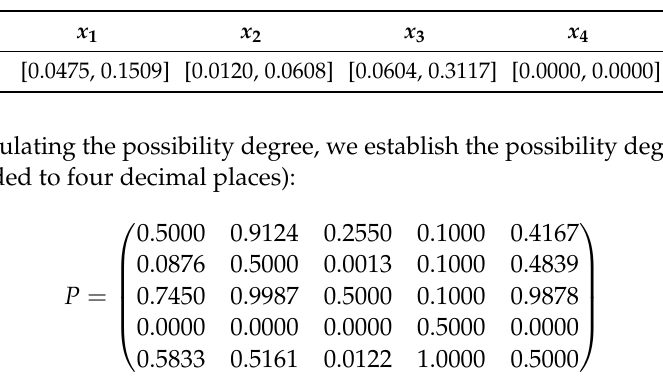
Table 2. Interval value vector of the comprehensive attribute.